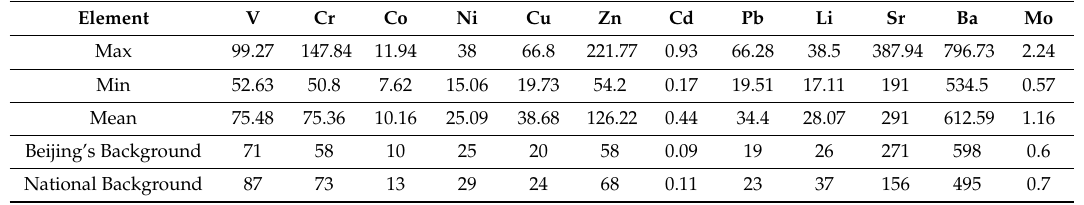
Table 4. Descriptive statistics of metal in the topsoil of the study area (mg ¨ kg ´ 1